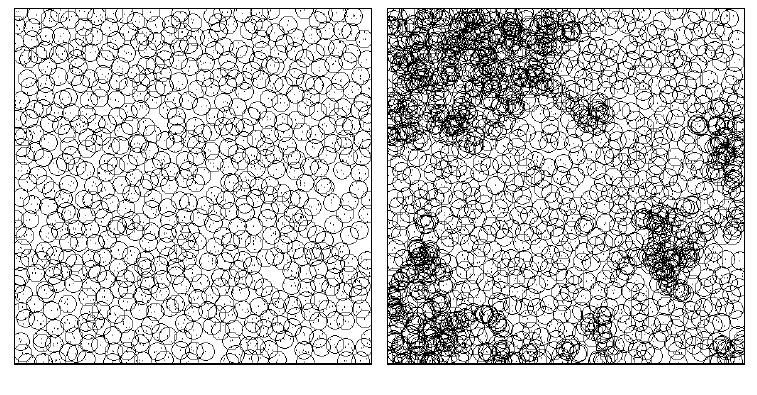
Figure 9. Clustering results of the proposed algorithm and SOS approach. (Distance is 12)